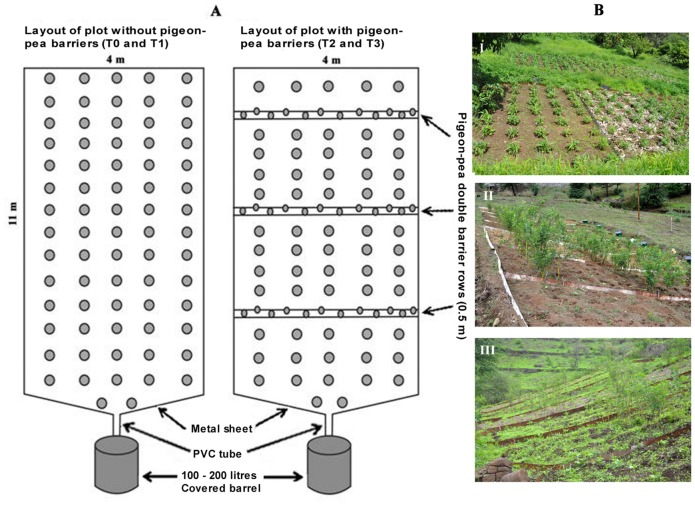
Layout and aspects of the experimental plots.(A) Schematic layout of the 11 × 4 m erosion plots (sites II and III) with and without hedges, and (B) field layouts of the plots at sites I, II, and III. Short title: